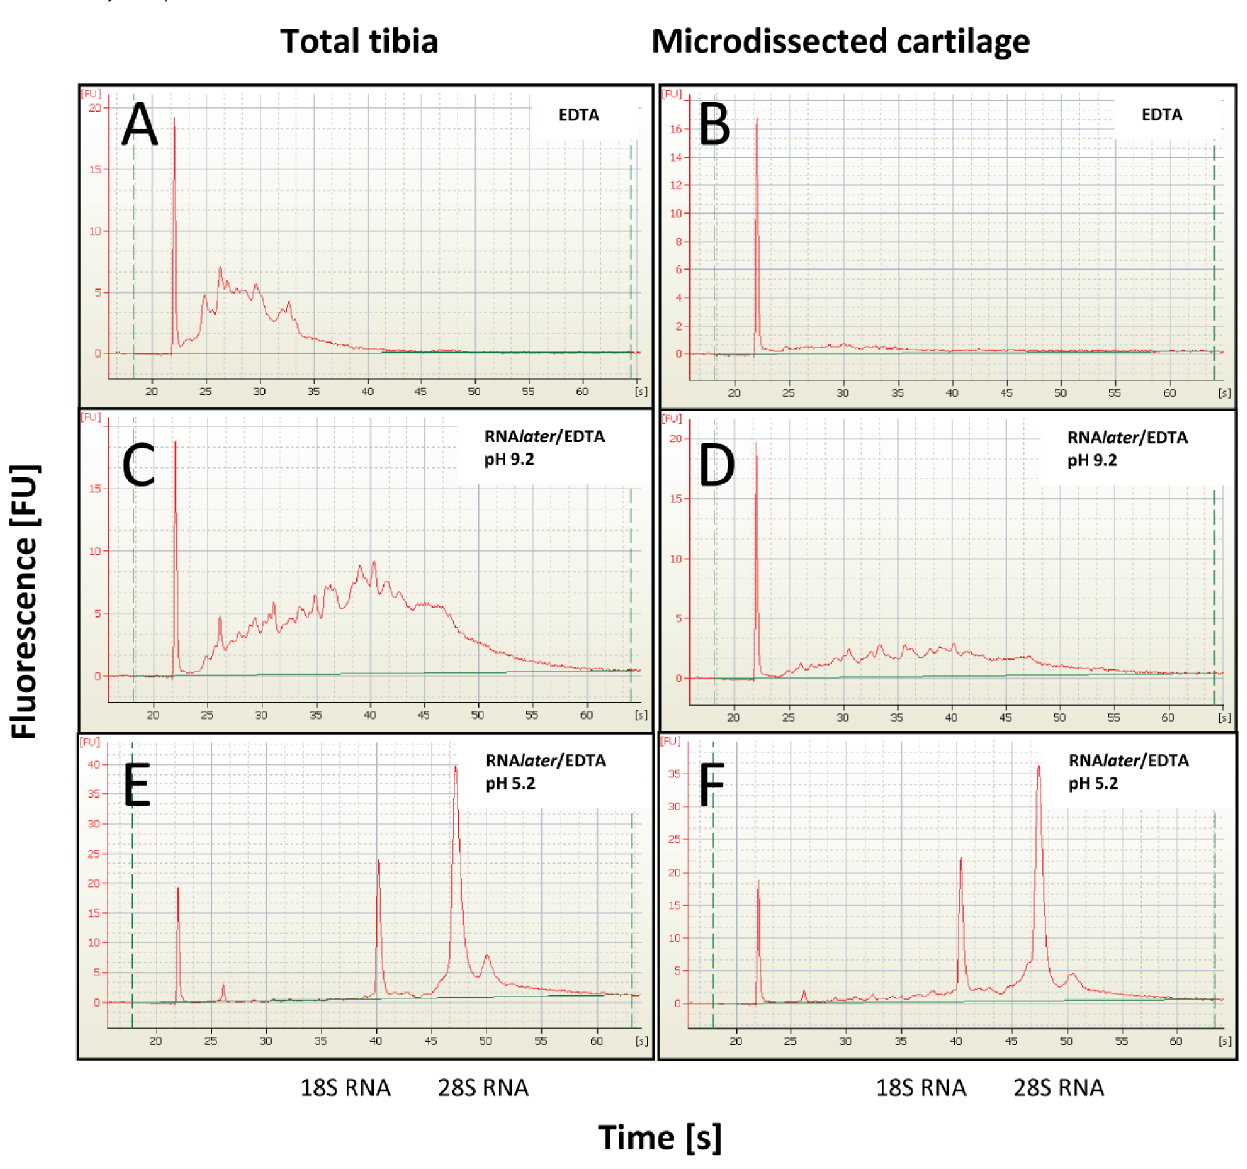
Figure 1. Analysis of RNA integrity. Microcapillary electrophoresis of total RNA isolated from whole tibial epiphysis (A, C, E) or cryosections of tibiae (B, D, F) decalcified with 0.5 M EDTA (A, B), RNA later /EDTA at pH 9.2 (C, D) or RNA later /EDTA at pH5.2 (E, F).